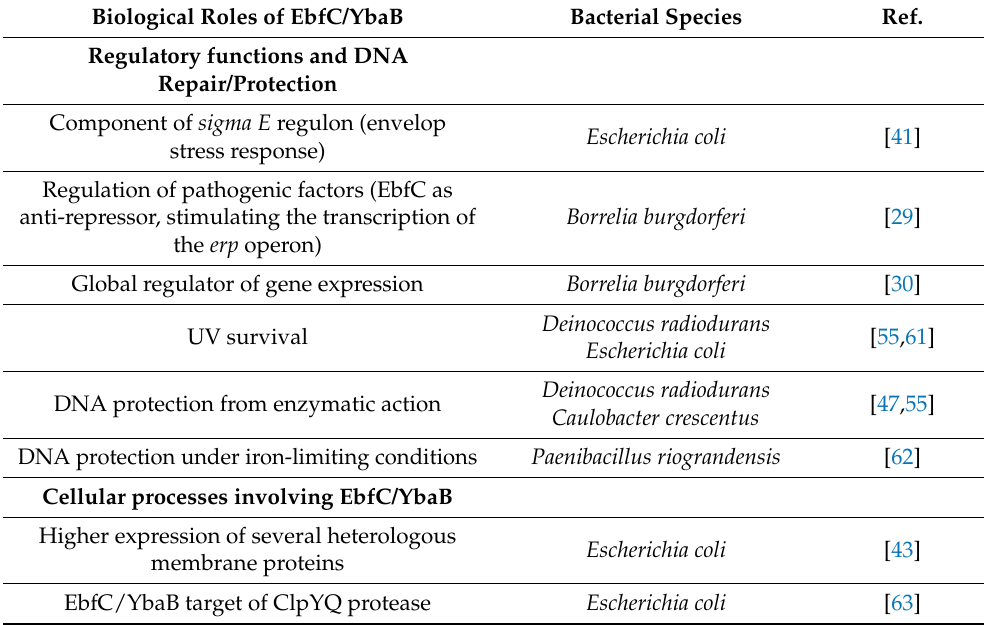
Table 1. Functions of EbfC/YbaB in gene regulation and in other cellular processes as described in the literature. Biological Roles of EbfC/YbaB Bacterial Species